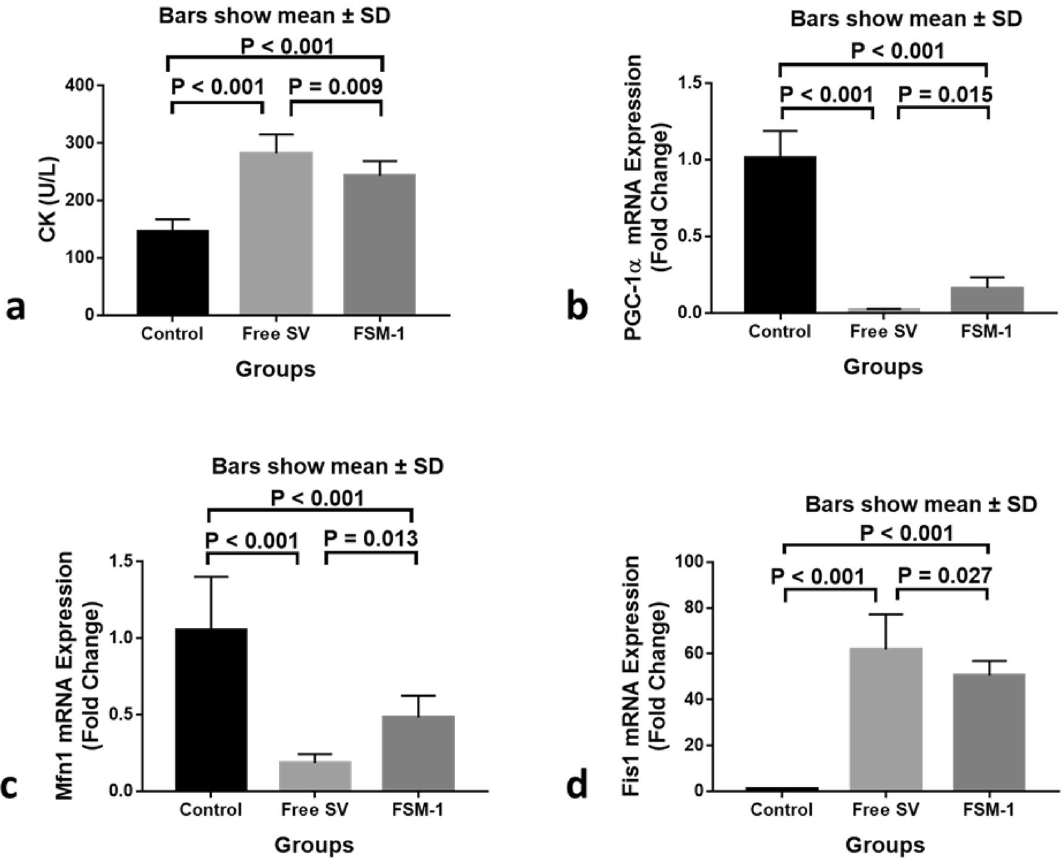
Figure 5. Serum levels of CK ( a ) and Gene expression levels of PGC-1α ( b ), MFn1 ( c ), and Fis1 ( d ) of the studied groups (n = 8). Data are given as mean ± SD. P < 0.05 is considered significant using a one ‐ way analysis of variance with LSD post hoc test (n is